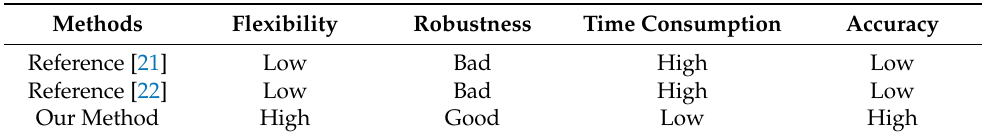
Table 1. Performance comparison of online hand–eye calibration